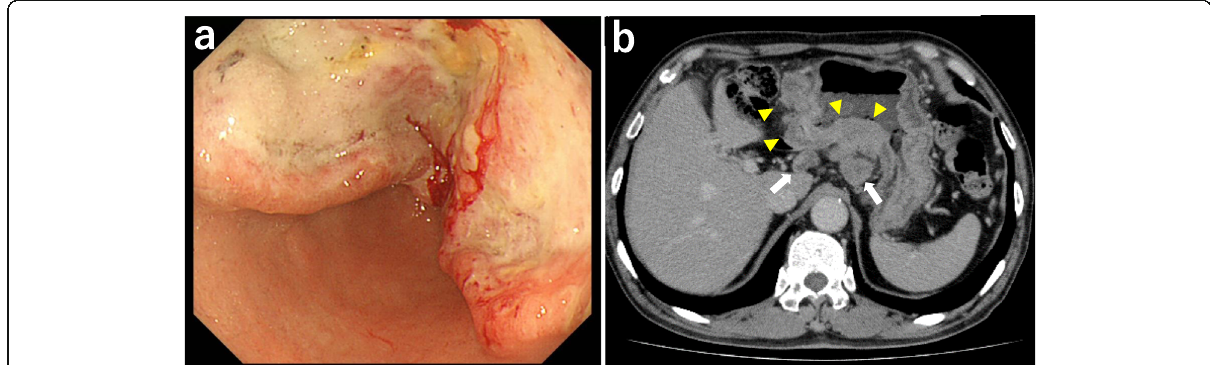
Fig. 1 Imaging before combined therapy. a Gastroscopy showed a large Borrmann type II lesion in the middle and distal stomach. b Contrast- enhanced computed tomography scan showed thickening of the wall of the stomach (arrowhead) and enlarged regional lymph nodes